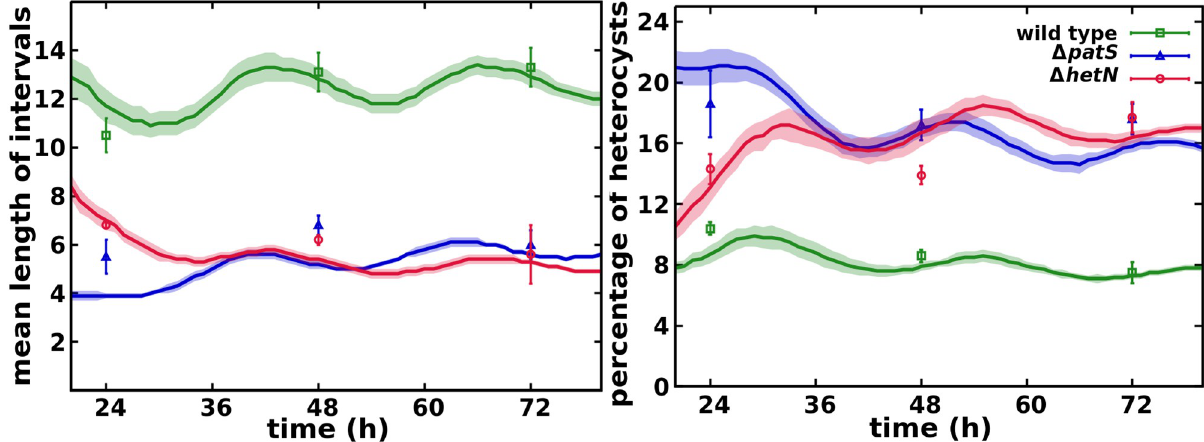
Fig 3. Mean number of vegetative cells between heterocysts and total percentage of heterocysts in the filament. Symbols represent experimental values from [50] and lines are simulation results with their standard deviation as a shadowed area.